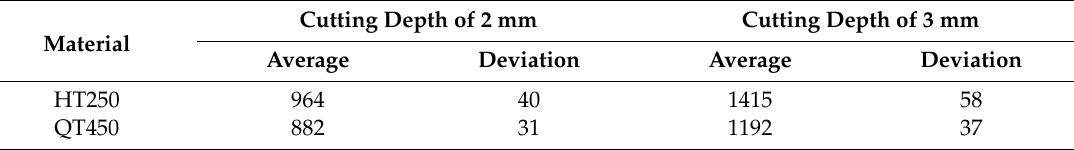
Table 6. The average value and standard deviation of the main cutting force,